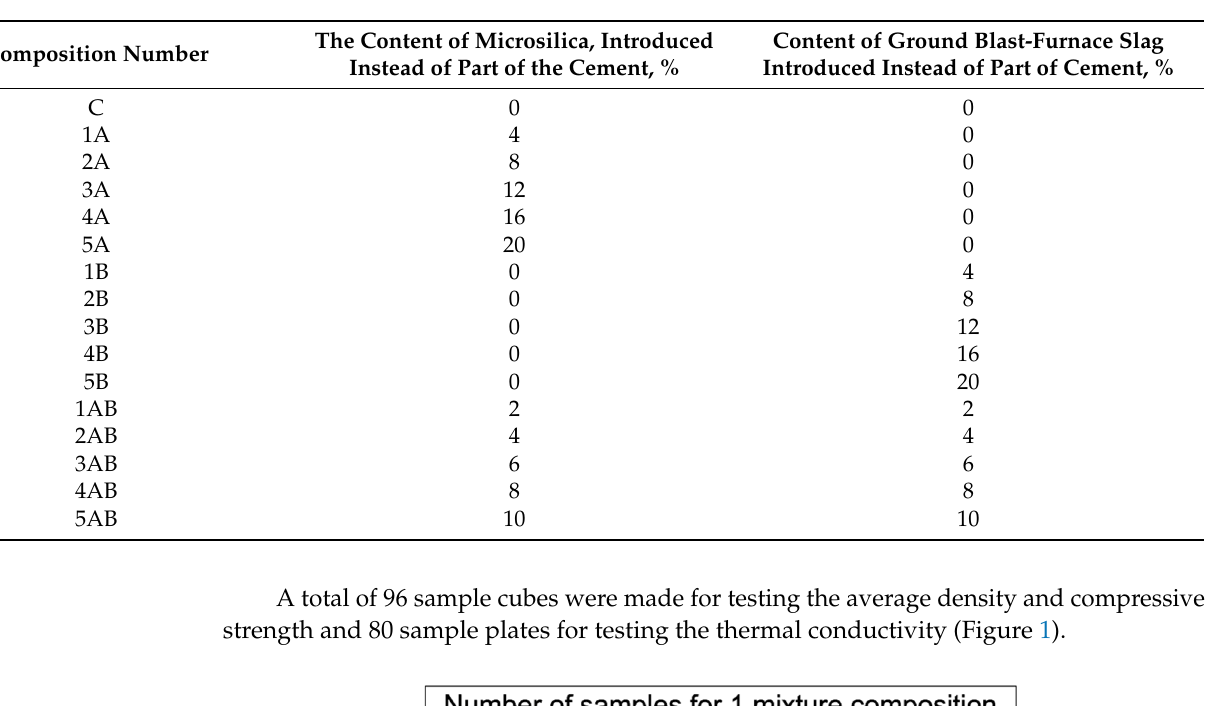
Table 8. Proportions of experimental compositions of mixtures.